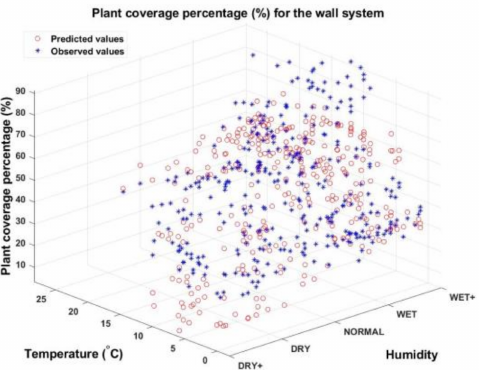
Figure 6. Observed values and predicted values by the regression model for plant coverage percent- age vs. humidity and temperature. Here, WkNo = 25 and Side = 1 are